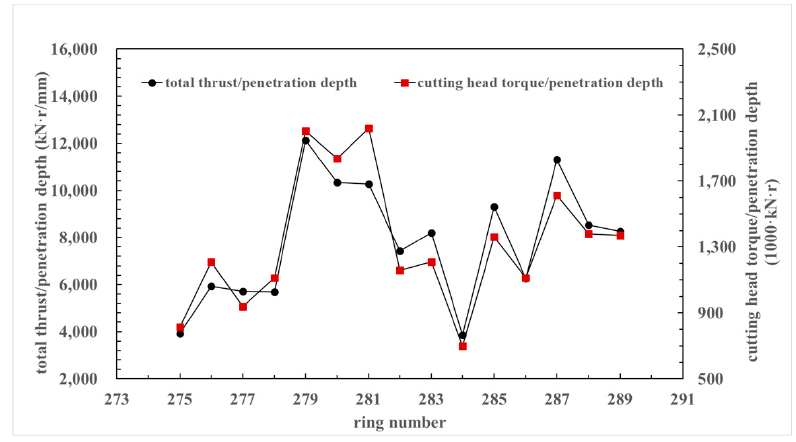
Figure 18. Changes of the two composite parameters at the Wuhan Metro Line 8 Yangtze River Crossing tunnel construction.